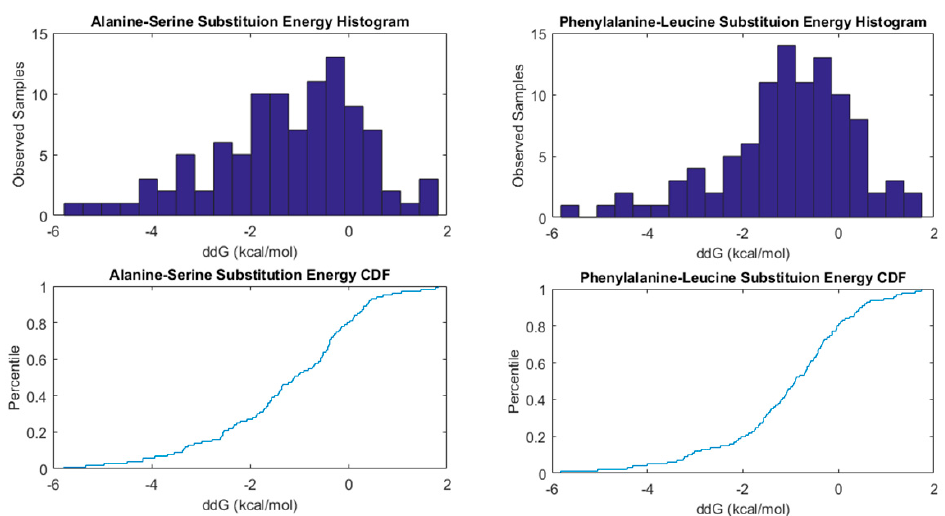
Figure 3. Alanine-Serine and Phenylalanine-Leucine amino-acid substitutions change cumulative distributions of energy changes and frequency histograms. These energy changes are observed in different protein sequences at different positions.